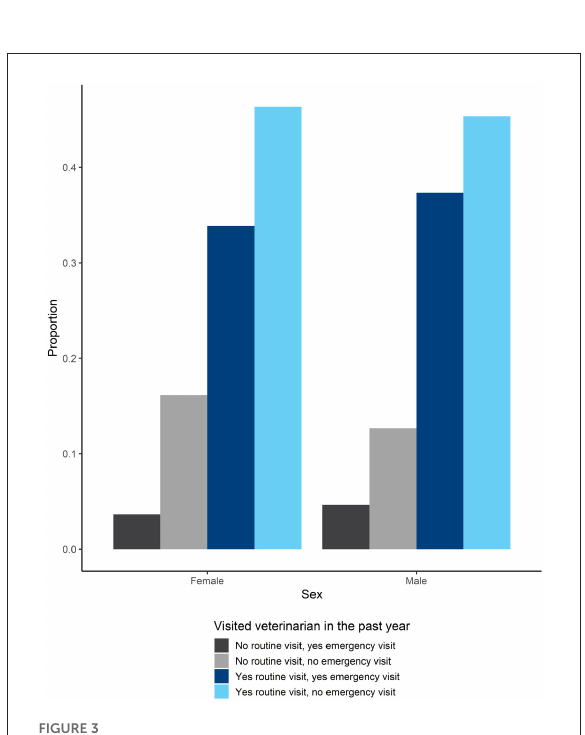
FIGURE3 Proportion of male and female dogs whose owners knew if they had visited a veterinarian in the past year for routine care and emergency